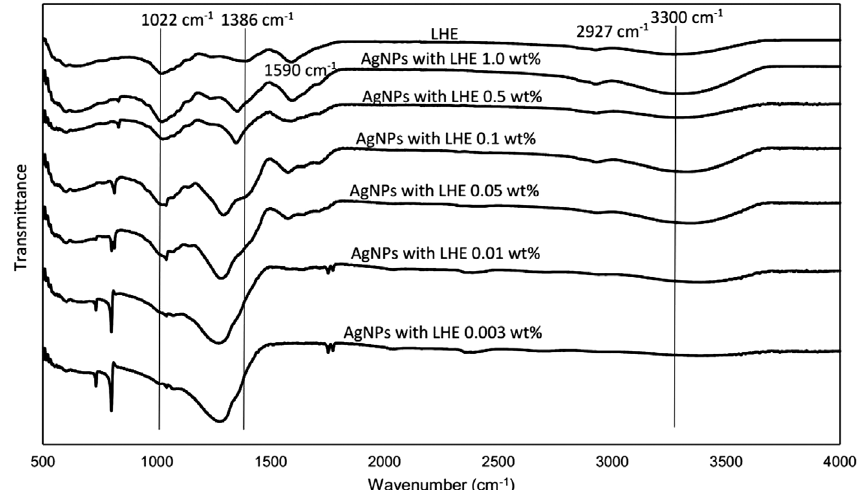
Figure 6: FTIR of LHE and silver nanoparticles obtained using the LHE extract.